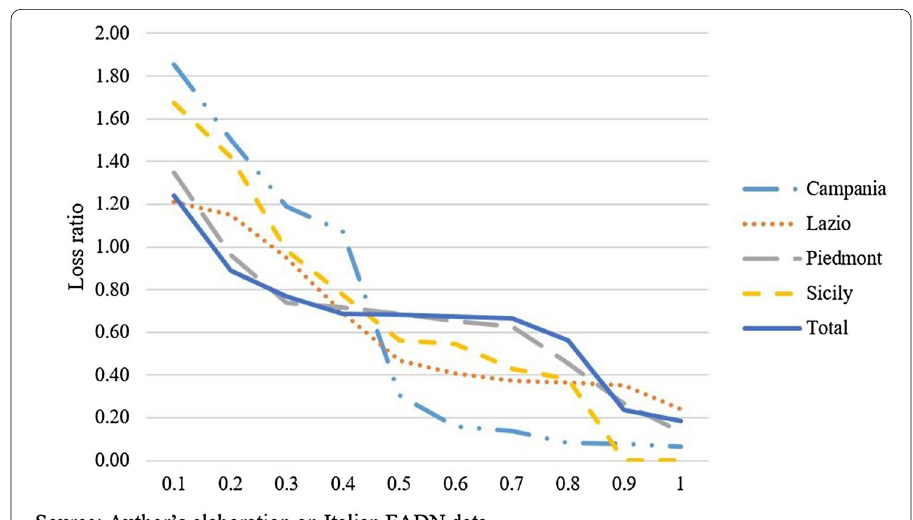
Fig. 2 Loss Ratio levels by region and for a national MF (total) from 2008 to